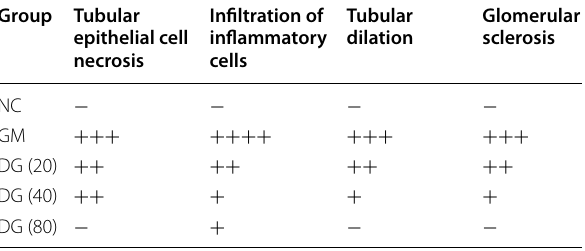
Table 1 Grading of histological features of kidney tissue sections in gentamicin-induced nephrotoxicity in rats Group Tubular epithelial